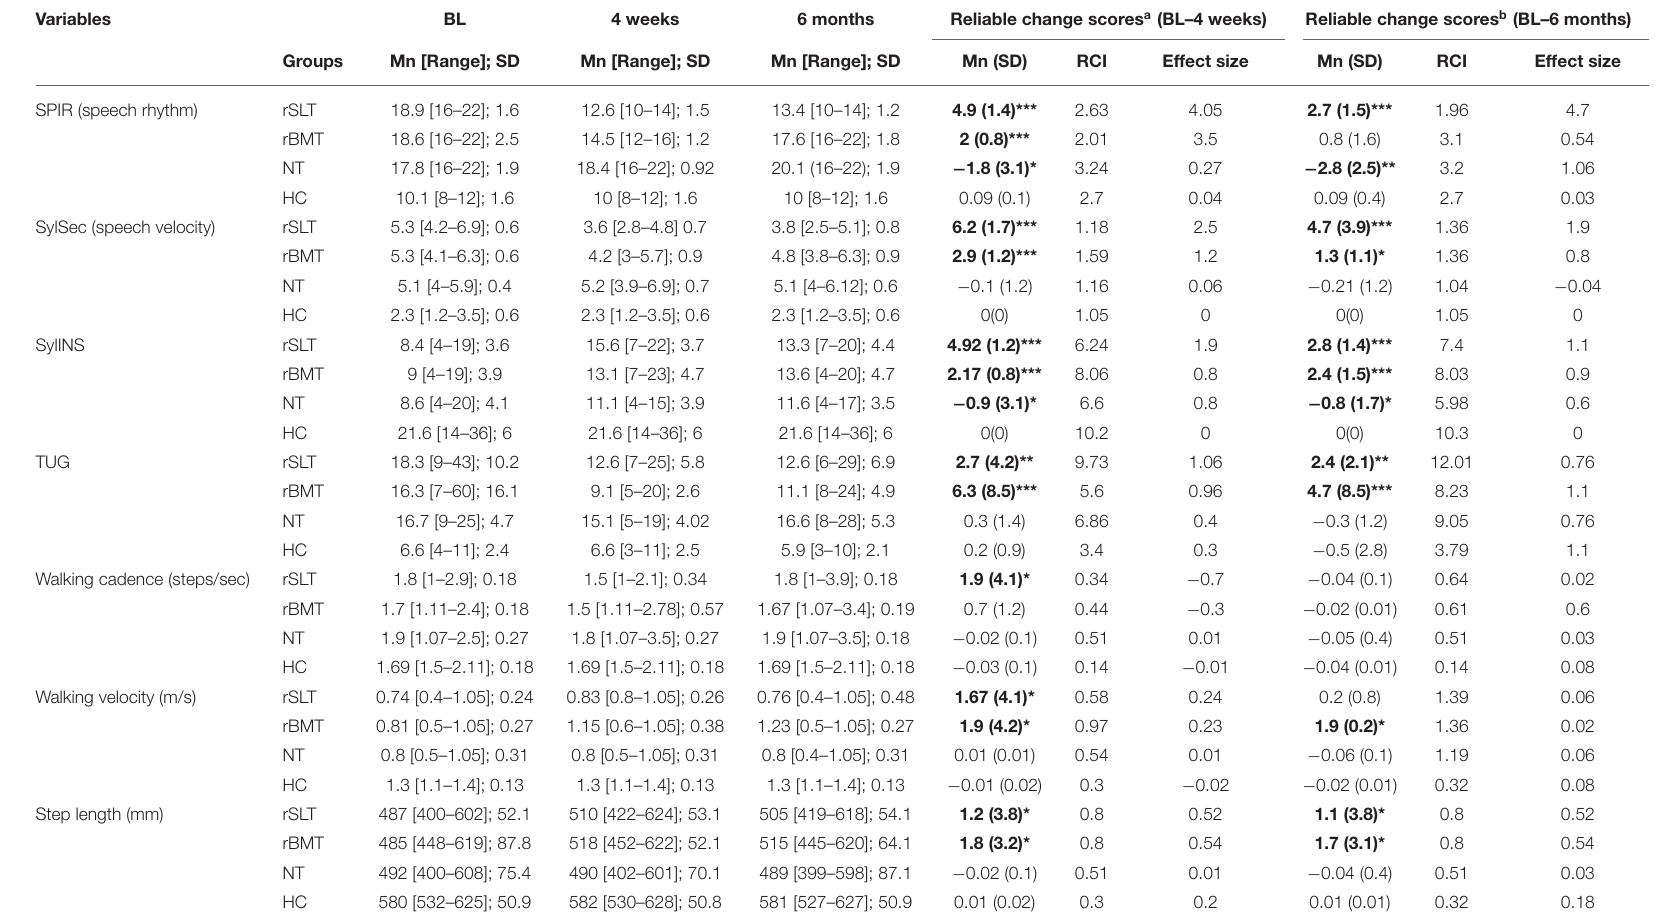
TABLE 5 | Group performances at baseline, 4 weeks, and 6 months per category as well as Reliable Change Scores and Reliable Change Index (RCI).